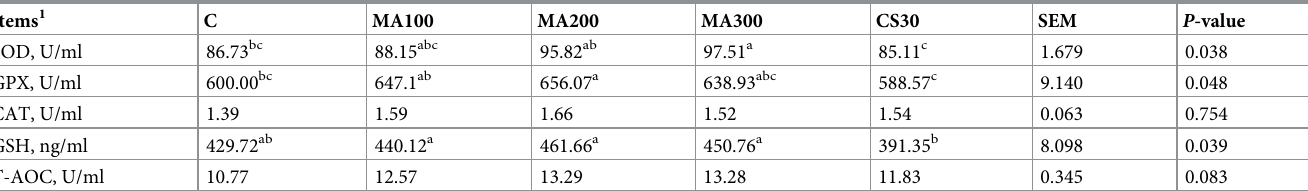
Table 6. Effect of dietary magnolol at different levels on serum antioxidant indices of 28 d Linwu ducks. Items